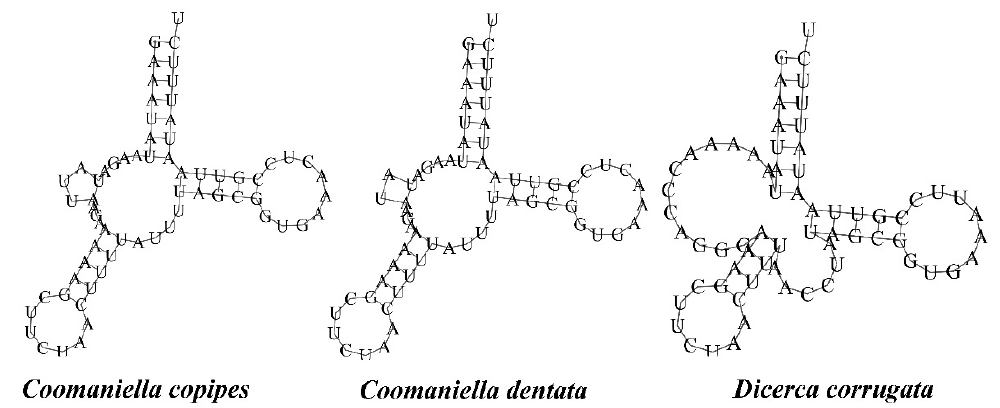
Figure 6. The trnS1 -predicted secondary structures of tRNAs in the mitogenomes of the three buprestid species.